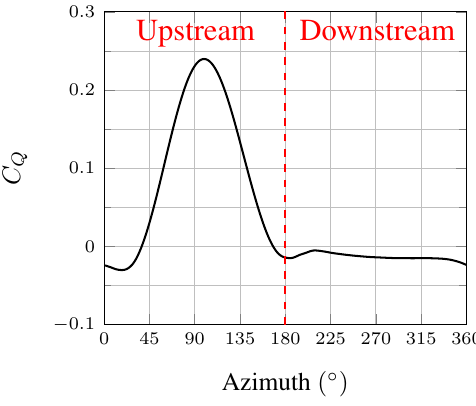
Figure 8. Torque coefficient ( C Q ) of blade 1 at λ = 3.